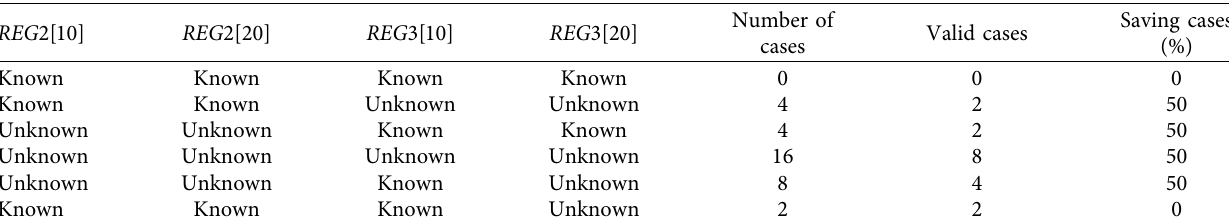
Table 1: Percentage saving in fnding unknown